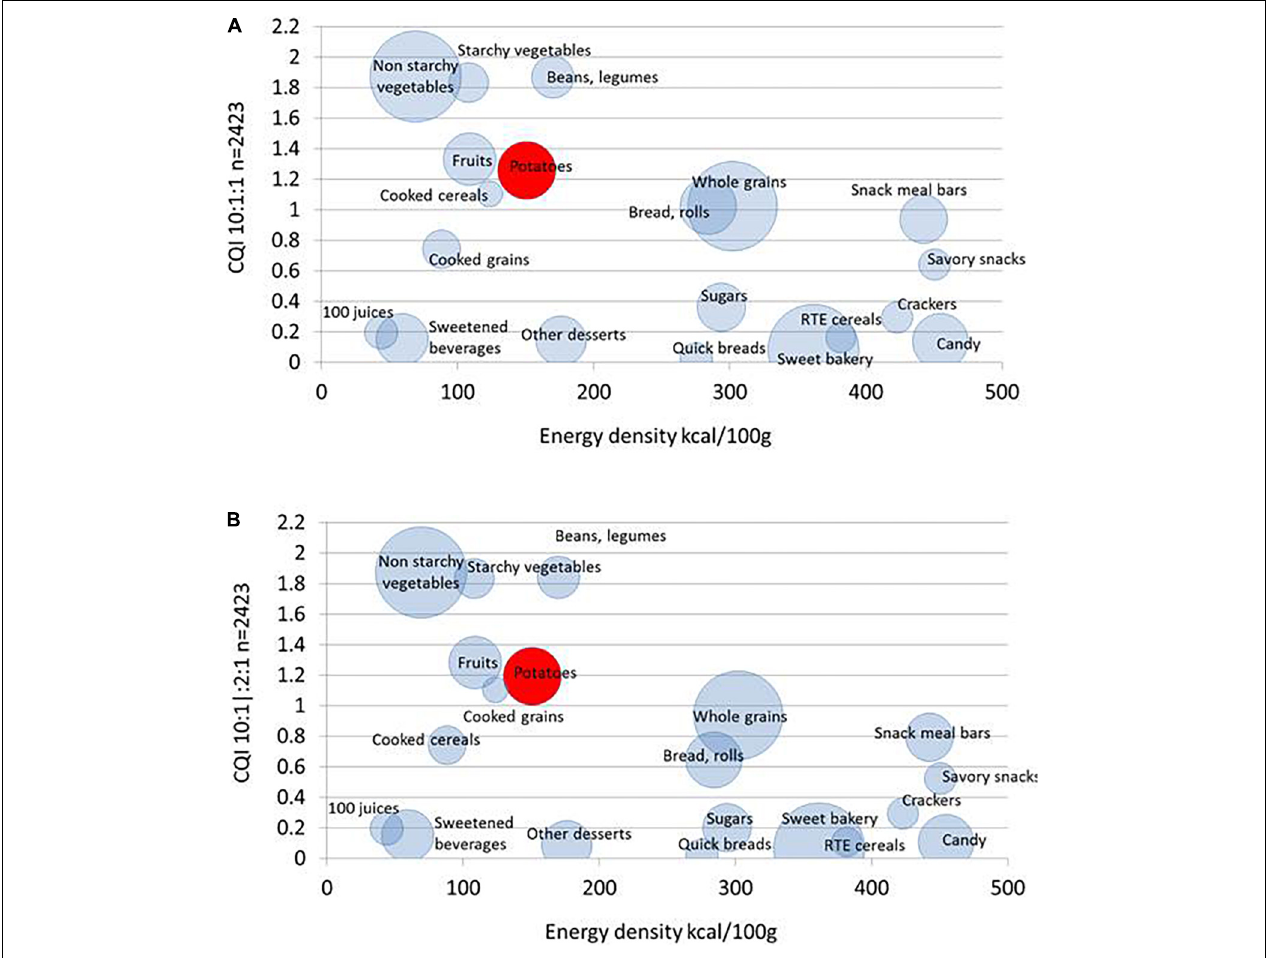
FIGURE 4 | Scatterplot of CQI 10:1:1 model scores (A) and CQI 10:1|2:1 model scores (B) plotted against energy density by WWEIA food category. The size of the bubble represents the number of items in the category.